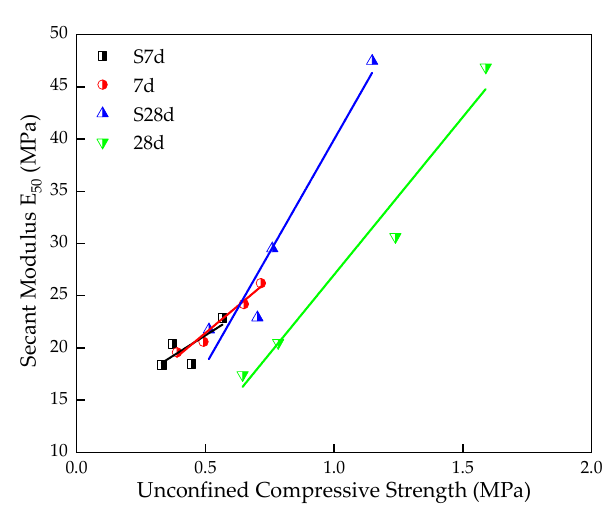
Figure 10. The relationship between UCS and E 50.